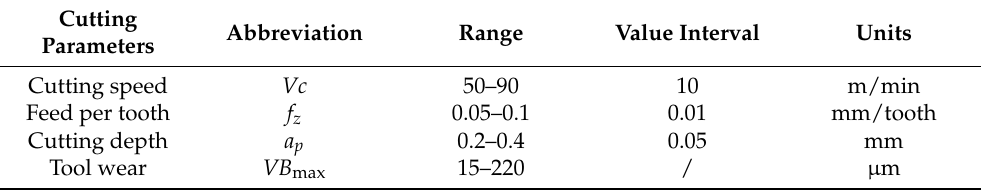
Table 5. Variation ranges of cutting parameters and tool wear during